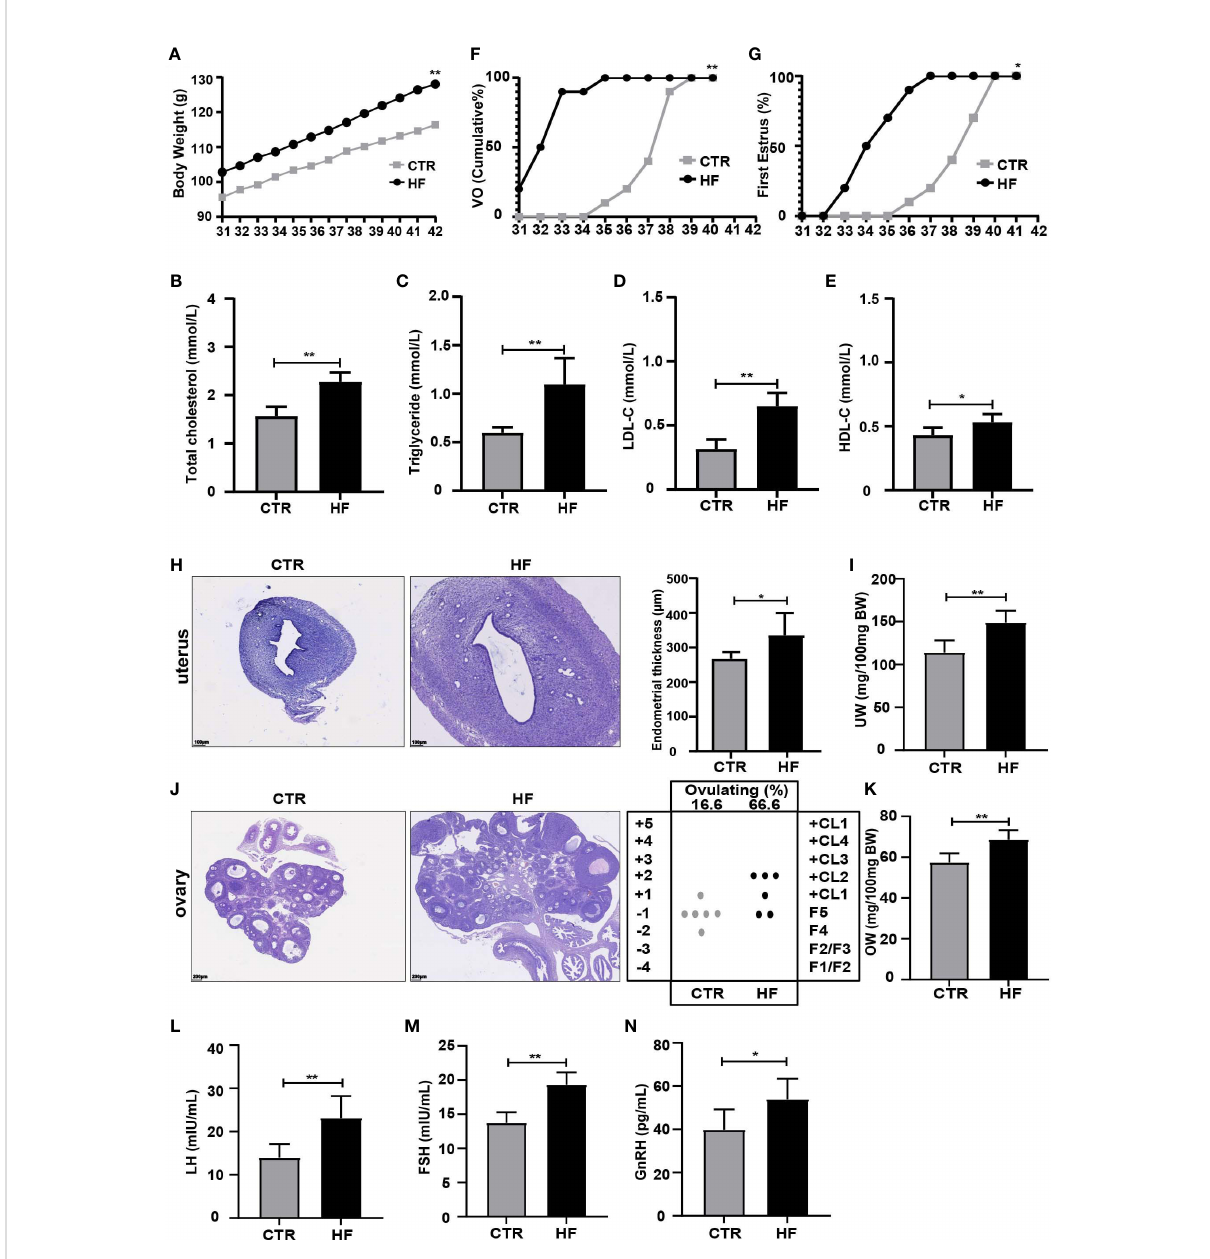
FIGURE 1 HFD induces obesity and precocious puberty in female rats. (A) Evolution of body weight. (B) Serum total cholesterol. (C) Serum triglyceride. (D) Serum low density lipoprotein cholesterol (LDL-C). (E) Serum high density lipoprotein cholesterol (HDL-C). (F) Cumulative percentage of vaginal opening. (G) Cumulative percentage of fi rst estrus. (H) Uterine wall thickness. (I) Relative uterus weight. (J) Histological score of follicular development and ovulation. (K) Relative ovary weight. (L) Serum LH levels. (M) Serum FSH levels. (N) GnRH secretion in the hypothalamus. n = 6 per group for rat samples. *P<0.05;